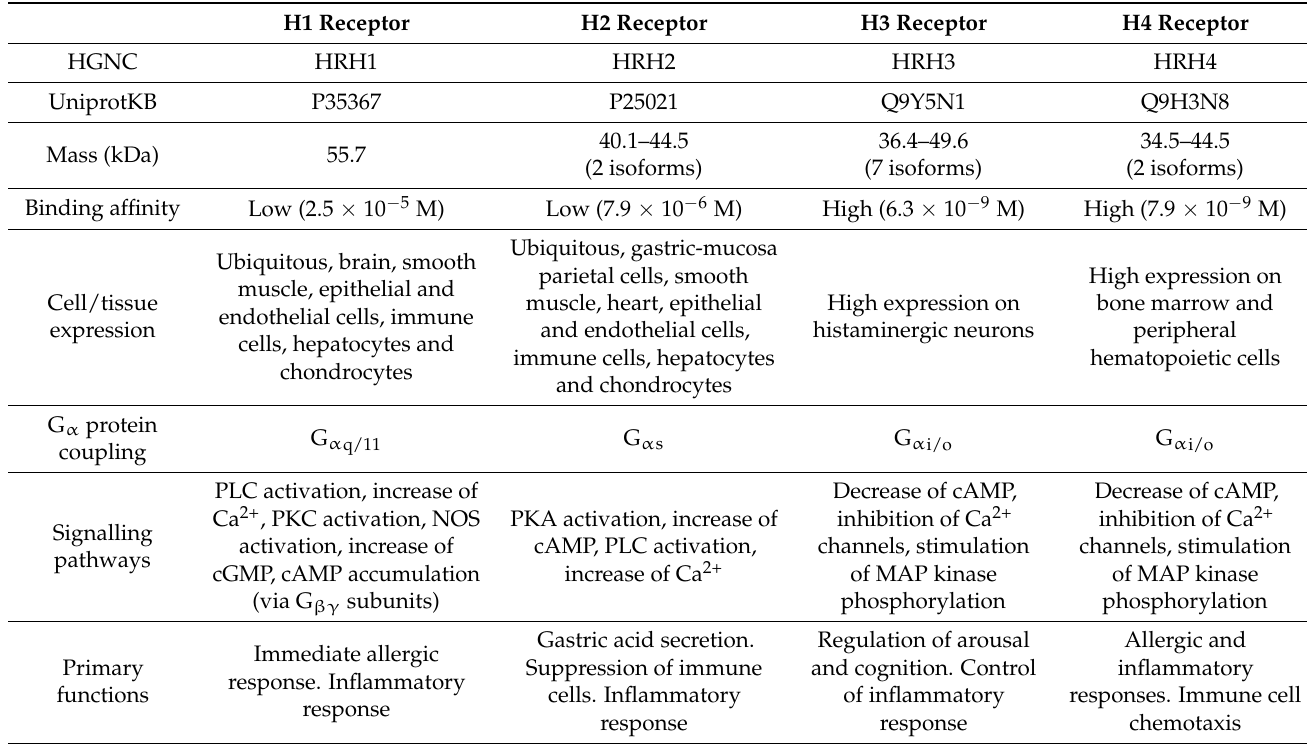
Table 1. Molecular and functional properties of human histamine